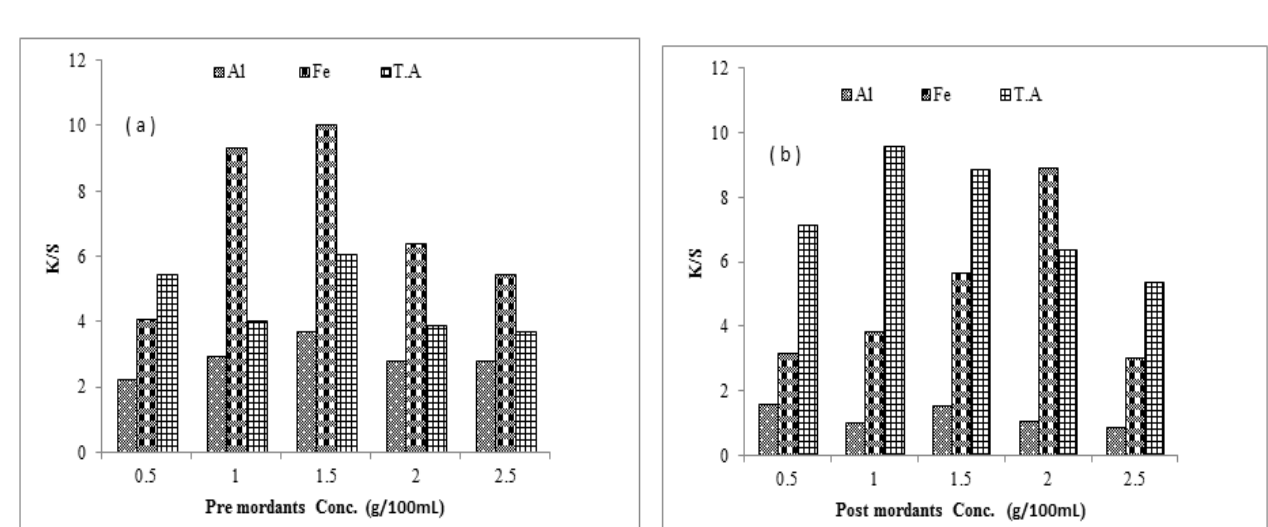
Figure 2. ( a ) Pre-bio-mordant of silk with black pepper extracts at optimized conditions. ( b ) Post- bio mordants of silk with black pepper extracts under selected conditions.